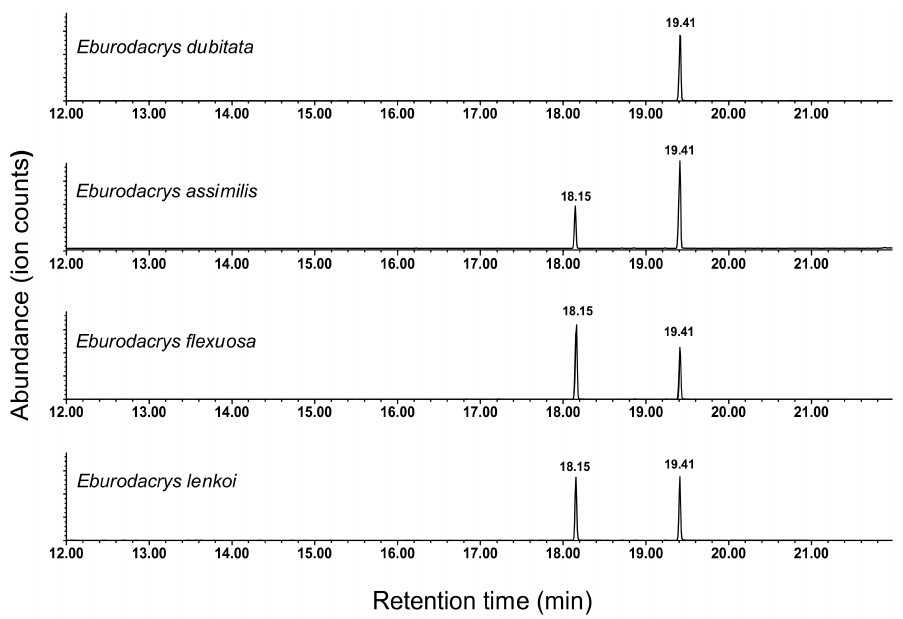
Figure 2. Representative total ion chromatograms of extracts of headspace odors from adult males of Eburodacrys dubitata , Eburodacrys assimilis , Eburodacrys flexuosa , and Eburodacrys lenkoi . The sex-specific peaks at 18.15 min (10-methyldocecanal) and 19.41 min (11-methytridecanal) were not present in equivalent extracts from females or system